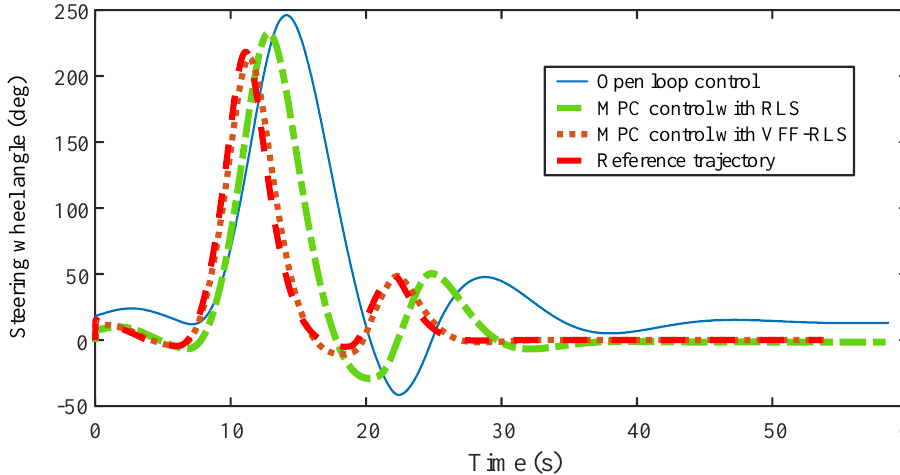
Figure 15. Steering wheel angle under Scenario B.